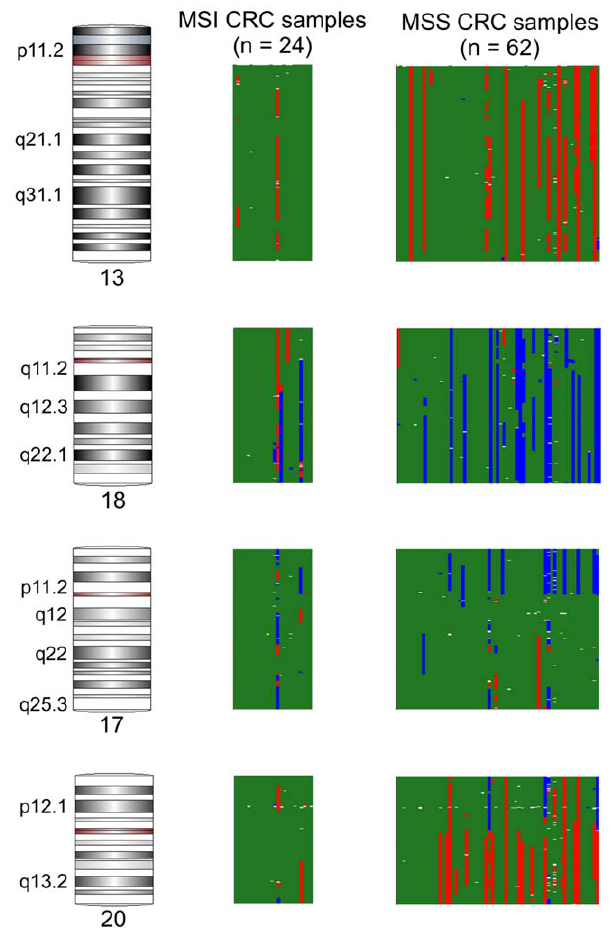
Figure 12. Genomic regions where the frequency of amplifica- tion or deletion is significantly different between MSI and MSS CRC samples. Amplification regions are shown in red; deletion regions are shown in blue; regions with no significant change are shown in green. Each column represents a single sample.